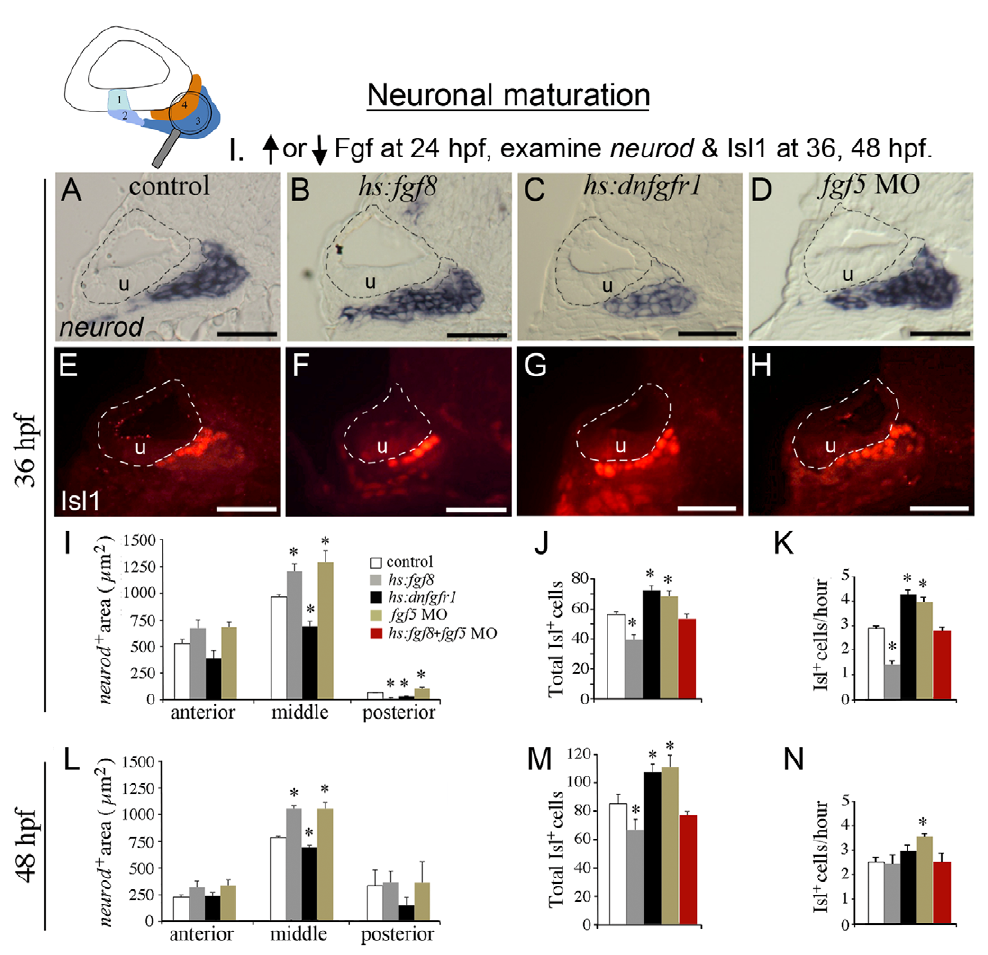
Figure 8. Fgf regulates the balance between transit-amplification and differentiation. The icon at the top of the figure indicates that neuronal maturation ( neurod + transit-amplifying cells and Isl1 + mature neurons) is the focus of analysis. Manipulations in these experiments (Neuronal maturation group I) are briefly summarized at the top. Embryos were heat shocked for 30 minutes at 39 u C (wild-type controls, hs:fgf8/ + embryos, and fgf5- morphants) or 38 u C ( hs:dnfgfr1/ + embryos) beginning at 24 hpf. (A–H) Transverse sections (lateral to the left, dorsal up) showing neurod expression (A–D) or Isl1 staining (E–H) at 36 hpf in control embryo (A, E), hs:fgf8/ + embryos (B, F), hs:dnfgfr1/ + embryos (C, G) and fgf5 morphants (D, H). All sections shown pass through the middle region of the SAG at the level of the utricular macula (u). The otic vesicle is outlined. Scale bar, 25 m m. (I–N) Quantitation of transit-amplifying and mature neuronal populations at 36 hpf (I–K) and at 48 hpf (L–N). Panel I shows a color key to facilitate comparison between treatments: White bars, control; gray bars, hs:fgf8 ; black bars, hs:dnfgfr1 ; brown bars, fgf5 morphants; red bars, activation of hs:fgf8 in fgf5 morphants. Analysis of transverse sections was used to measure the mean area of neurod + precursor cells (I, L) in the anterior, middle and posterior regions of SAG. The total number of Isl1 + neurons (J, M) and the mean hourly rate of neuron production from 24 hpf to 36 hpf (K) and from 36 to 48 hpf (N) was measured by counting neurons in stained wholemount specimens. Error bars in I, J, L, M indicate standard deviations (n=3 or greater for sectional areas; n=15 for Isl1 + cell counts). *p , 0.05 in comparison to control, analyzed with Student’s t test. Error bars in K, N indicate standard errors.